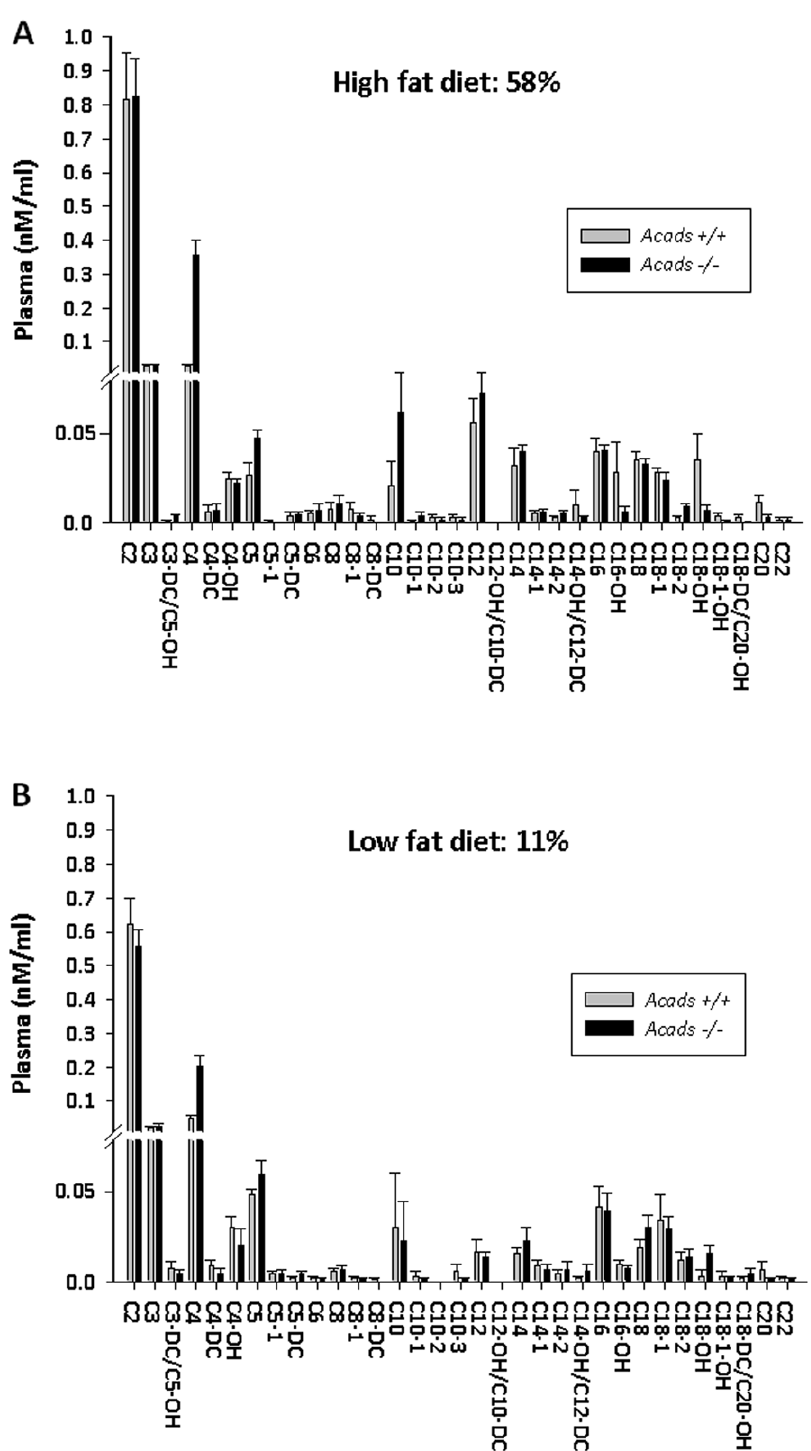
Figure 1. Effects of genotype and diet on plasma acylcarnitine levels. Acylcarnitines were measured by tandem mass-spectrometry in plasma from Acads 2 / 2 and Acads + / + mice fed high- (A) or low-fat (B) diet. Values are means (pmol/mg protein) 6 SEM. n=12 animals per group. ** P , 0.0001, * P , 0.01, # P , 0.05 for genotype comparisons. See Table S3 for a summary of ANOVA results for these variables.